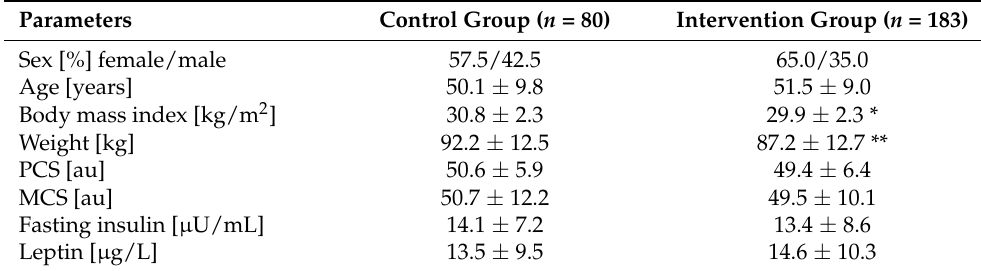
Table 1. Baseline characteristics.